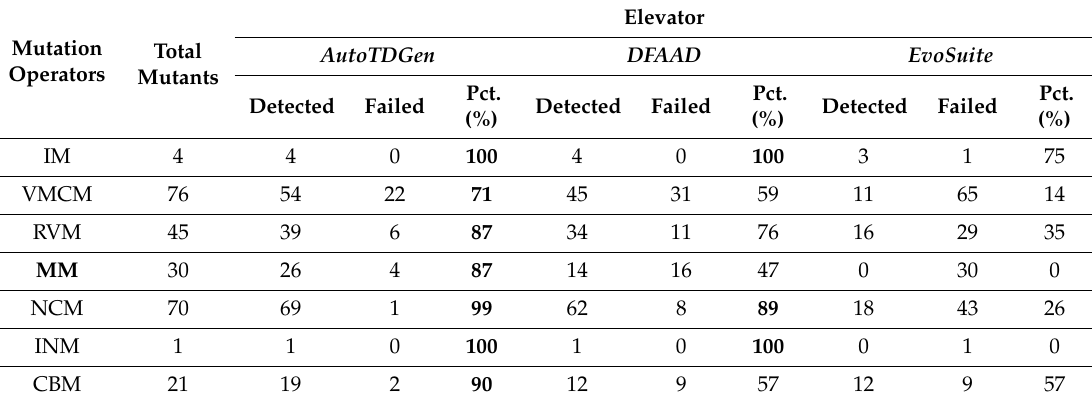
Table 6. Comparison results for the types of mutations covered in Elevator.